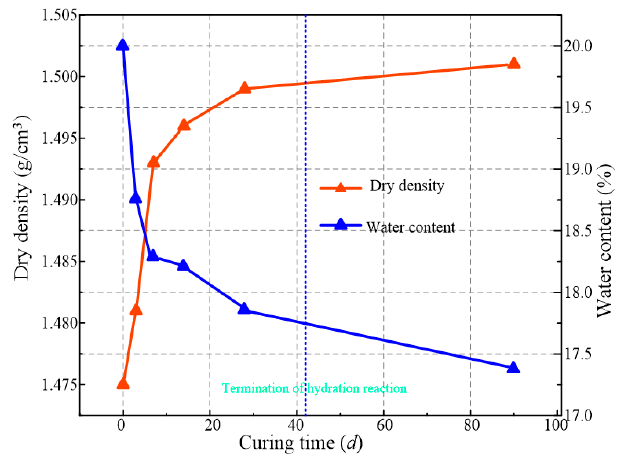
Figure 6. Variation of dry density and water content of waste ‐ based binder solidified/stabilized gold tailings.